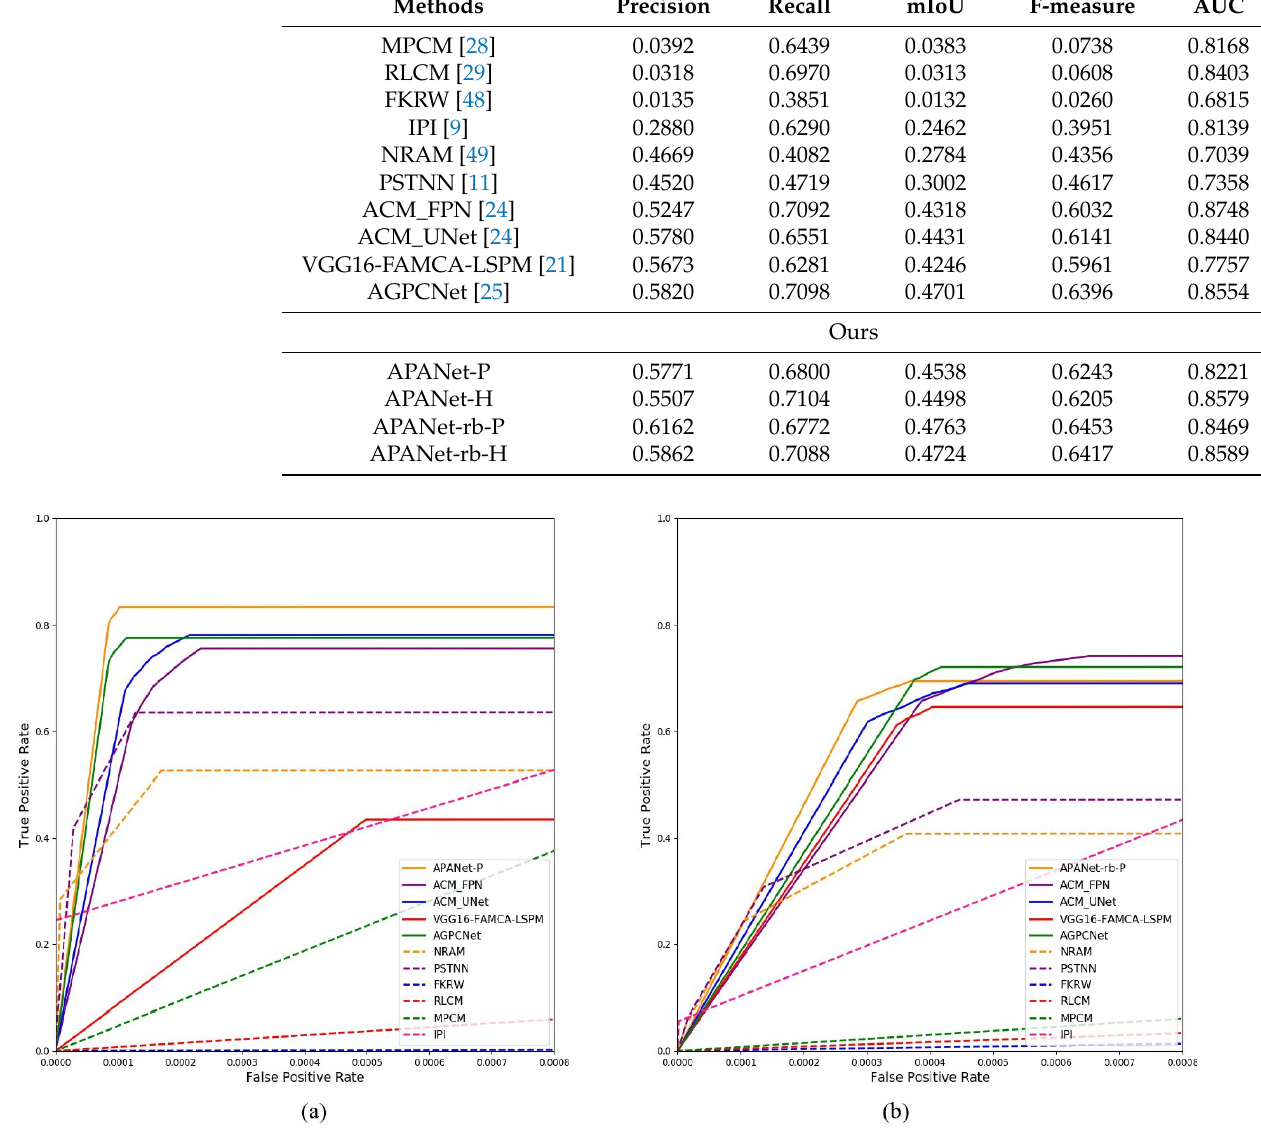
Figure 7. Illustration of ROC curve compared with other methods. ( a ) Comparison of different methods on SIRST dataset. ( b ) Comparison of different methods on MDFA